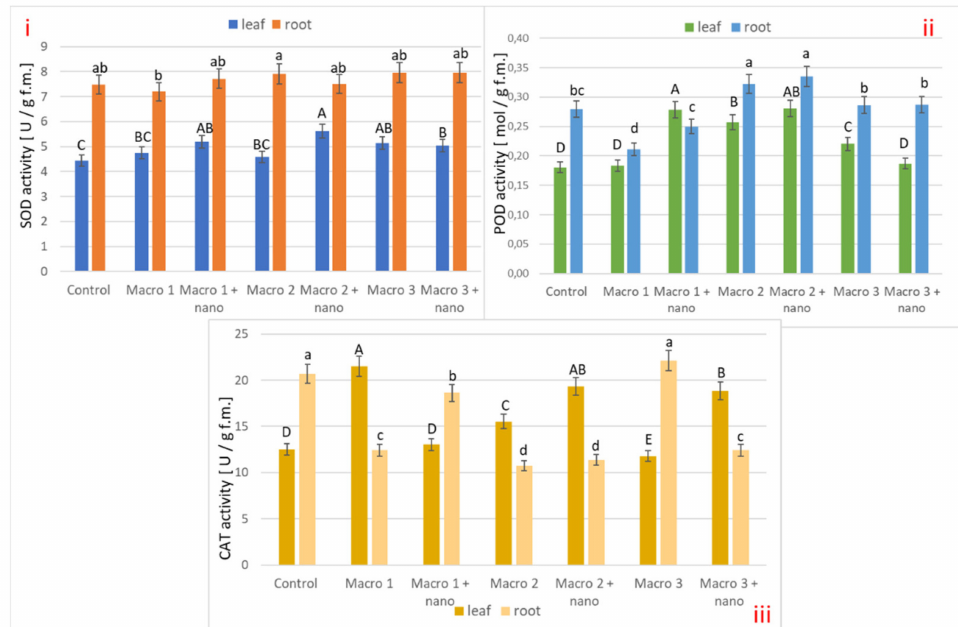
Figure 7. The content of superoxide dismutase [U g − 1 fresh weight] ( i ), pyrogallol peroxidase [mol g − 1 fresh weight] ( ii ) and catalase [U g − 1 fresh weight] ( iii ) in the shoots and roots of plants grown in soil supplemented macronutrients or macronutrients and nanoparticles. Vertical bars represent the mean values (n = 5) ± standard deviations. Different letters indicate significant difference at p < 0.05 by LSD